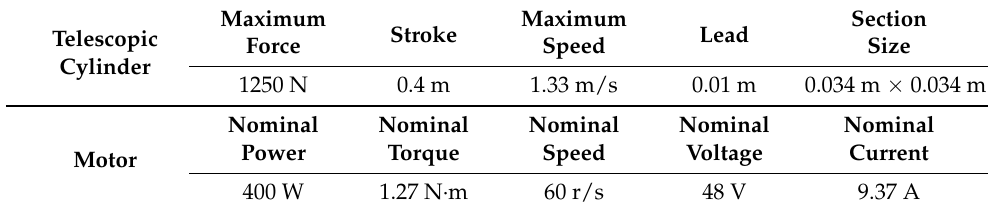
Table 1. Main parameters of the PC25 telescopic cylinder and APM-SB04A motor.